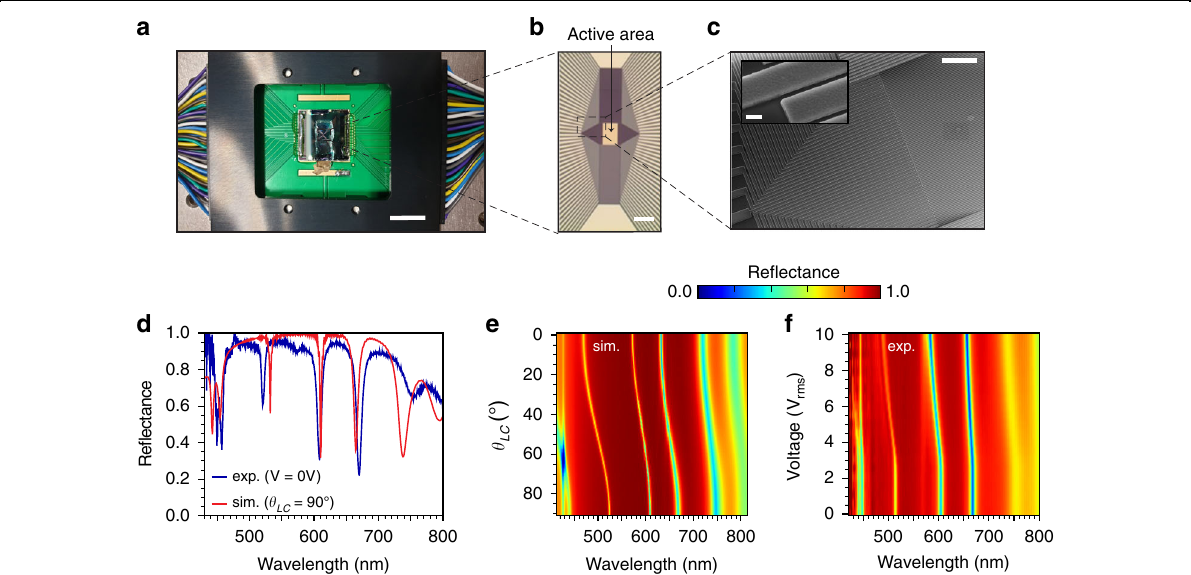
Fig. 2 Performance of the fabricated device. a Optical image of the device mounted on the PCB board and connected to the voltage supply. The group of wires provides voltage to the individual electrodes (scale bar: 10 mm). b Optical microscope image of the fabricated 96-electrodes FP-SLM device, showing the electrodes and the active area (scale bar: 100 μ m ). c Top view SEM image of the fabricated device (scale bar: 25 μ m ). The inset shows a magni fi ed tilted view SEM images (scale bar: 500 nm). The measured thickness of the Al electrodes is 158 nm. d Re fl ectance spectra for the FP-SLM. In red, simulated re fl ection assuming h LC = 530 nm and θ LC = 90°. In blue, the measured spectra when no bias is applied to the device. e Simulated and ( f ) measured re fl ectance spectra as a function, respectively, of θ LC and bias applied (V rms ). In the experiment, all pixels are simultaneously